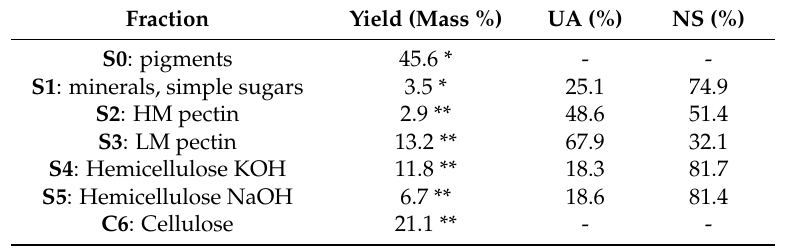
Table 1. Yield (expressed in mass %) and composition of the cell wall extracts of argan leaves. Fraction Yield (Mass %) UA (%) NS (%) S0 : pigments 45.6 * -